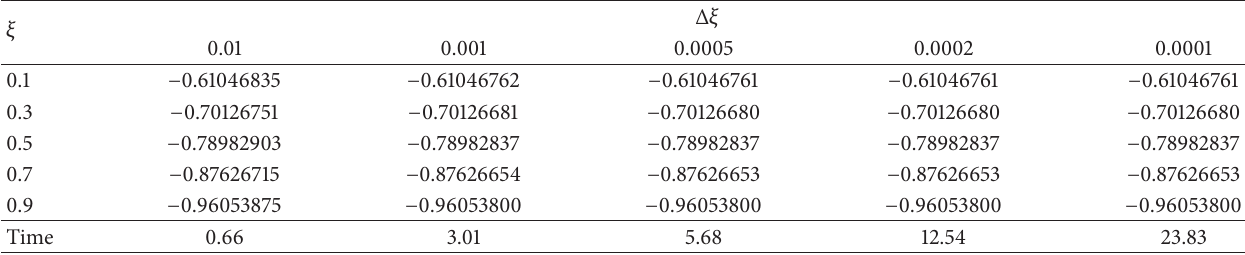
Table 1: Skin friction 𝑓 󸀠󸀠 (0, 𝜉 ) for various values of 𝜉 computed using SRM.